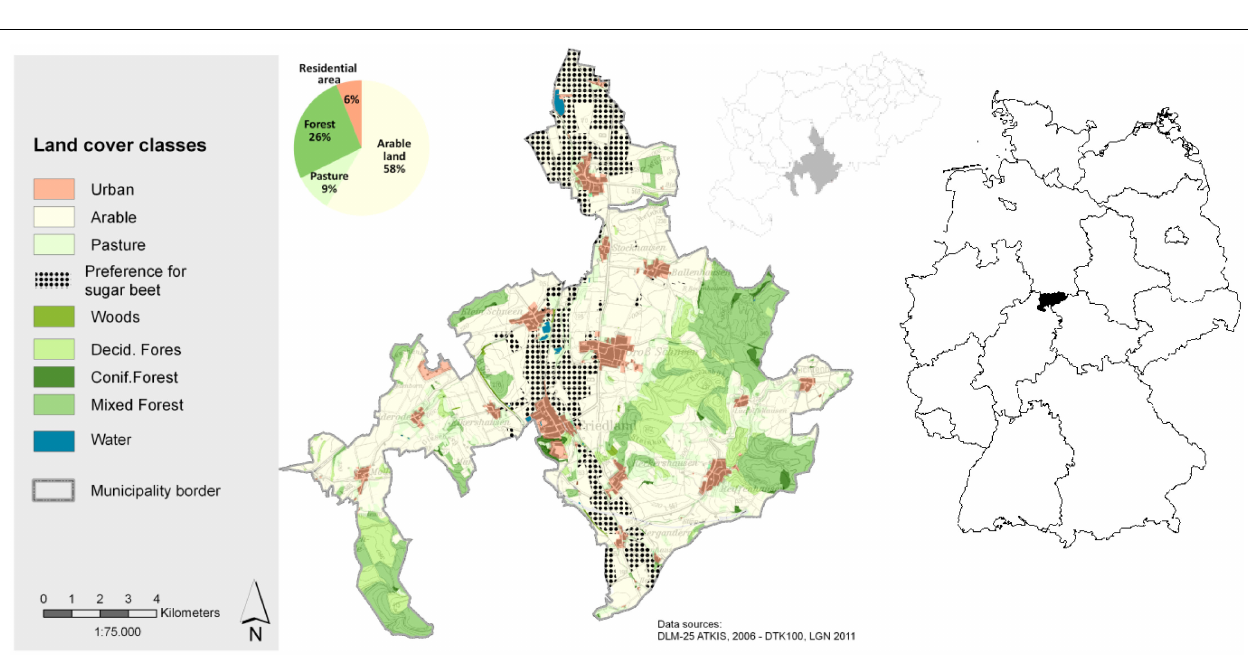
FIGURE 2 | Landscape mosaic in the municipality of Friedland including preference sites for sugar beet–wheat rotations that are excluded from the scenario assessment .